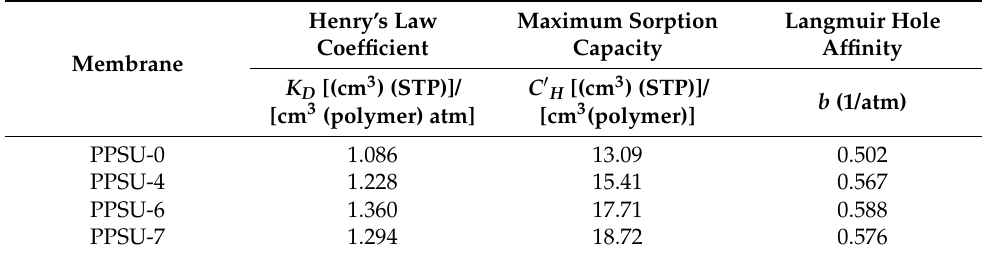
Table 6. Dual-mode sorption model for CO 2